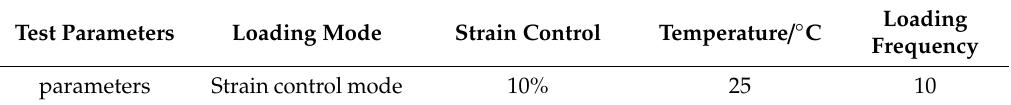
Table 11. Time scanning test parameters.